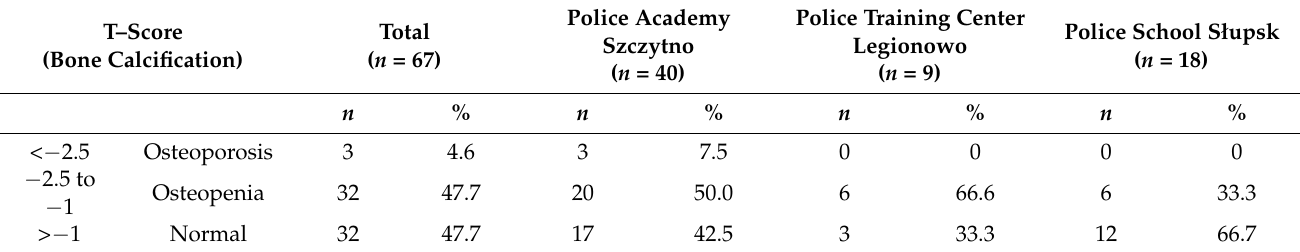
Table 5. Assessment of the bone calcification of female police officers ( n = 67).